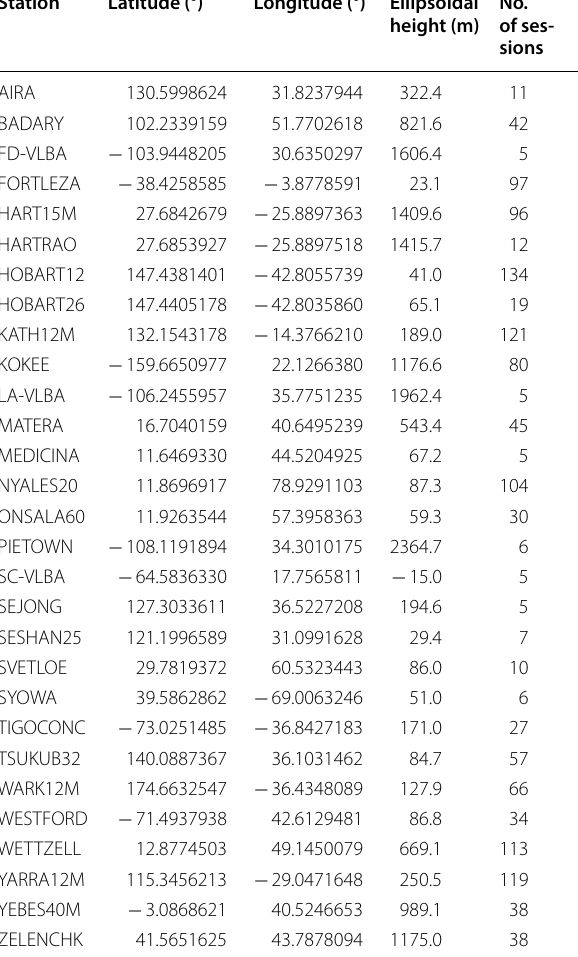
Table 3 Geodetic coordinates of the VLBI position domain analysis stations and number of sessions participated in